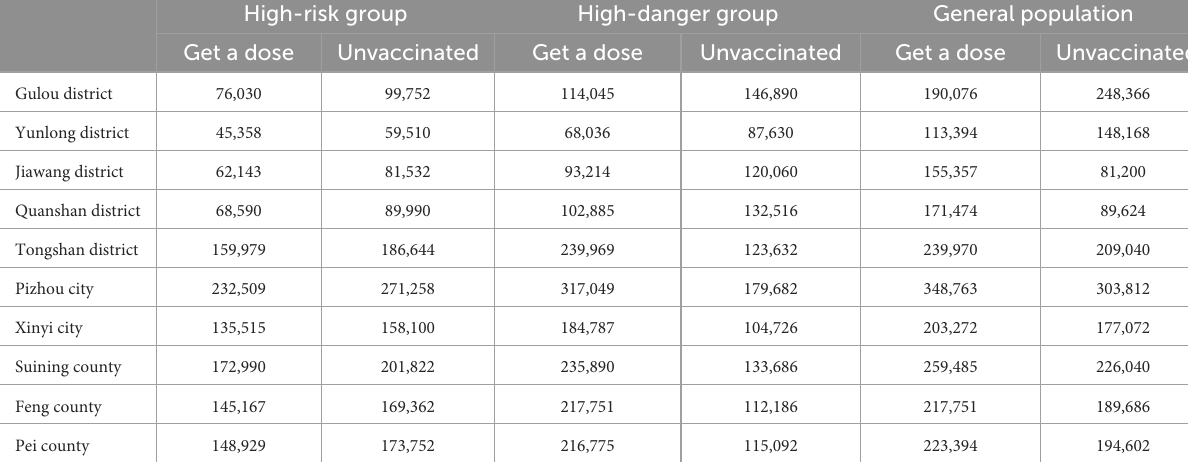
TABLE 9 Distribution of vaccines by region.